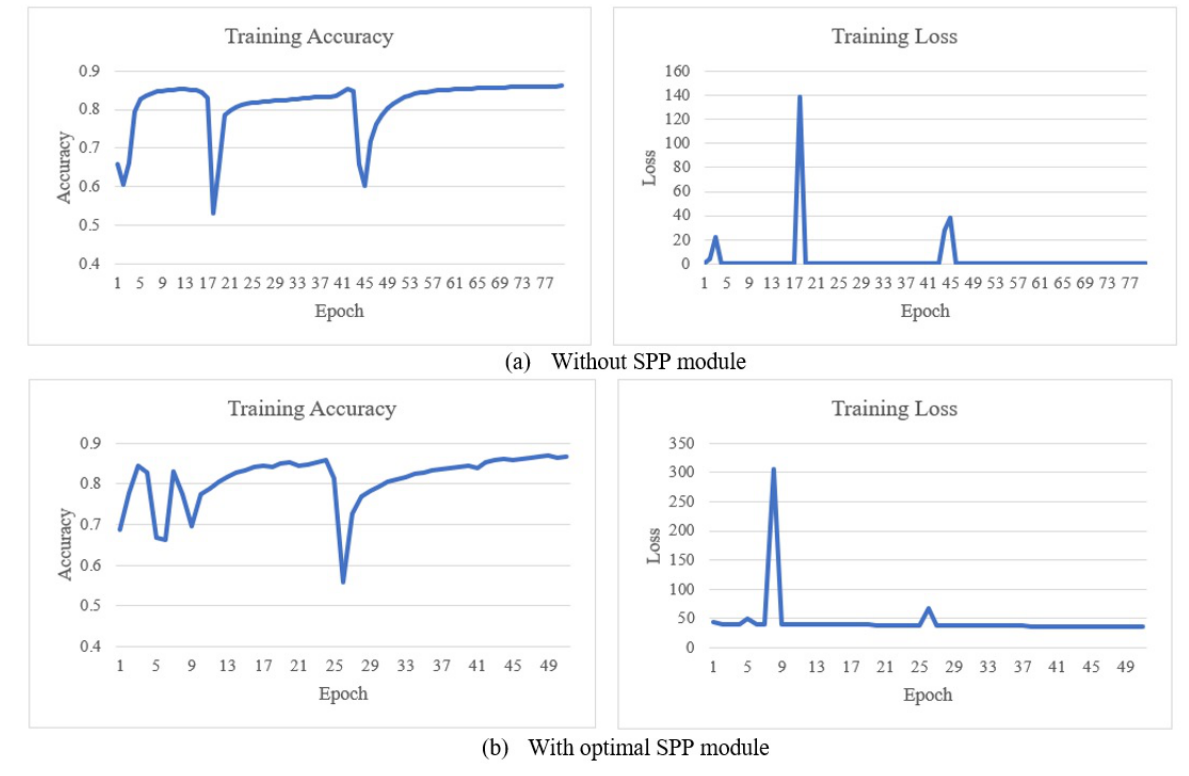
Figure 5. Training accuracy and loss of forest monitoring system using moderately difficult dataset.